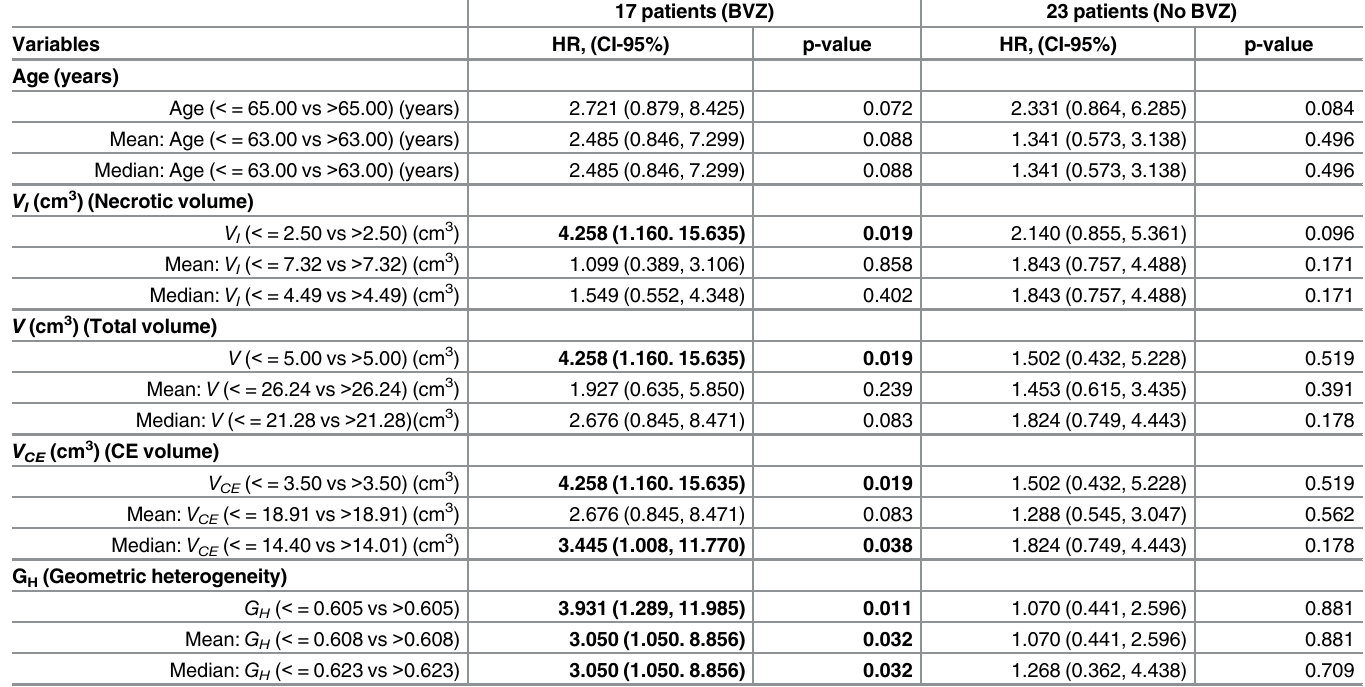
Table 4. Summary of univariate Cox and Kaplan-Meier analysis for the more representative variables included in the study. Significant results are